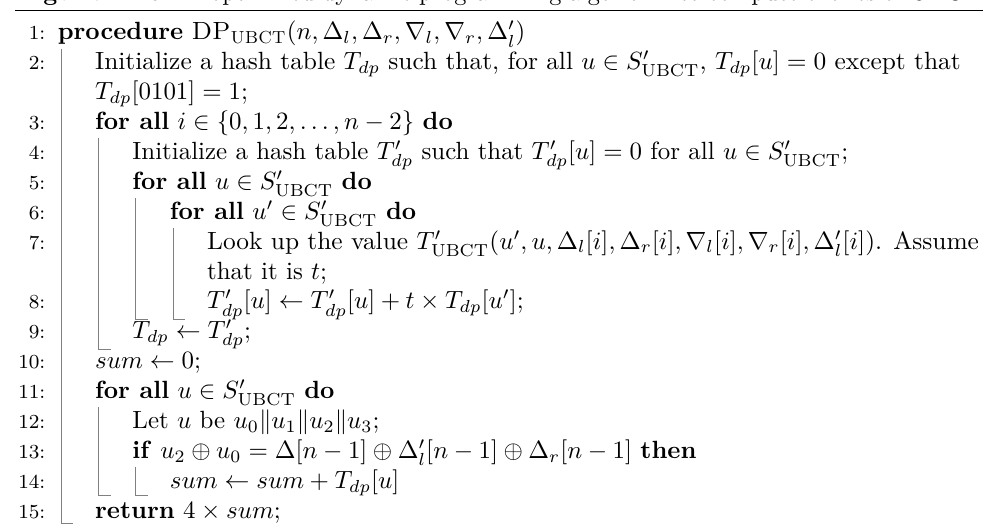
Algorithm 5 An optimized dynamic programming algorithm to compute entries of